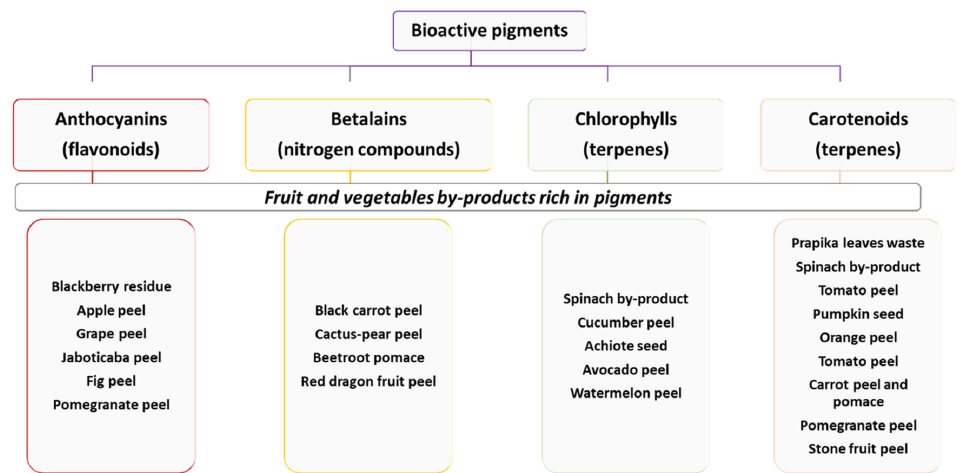
Figure 2. Types of the main bioactive pigments and examples of some fruits and vegetable (F&V) by-products rich in these pigments [8,32,38,39].